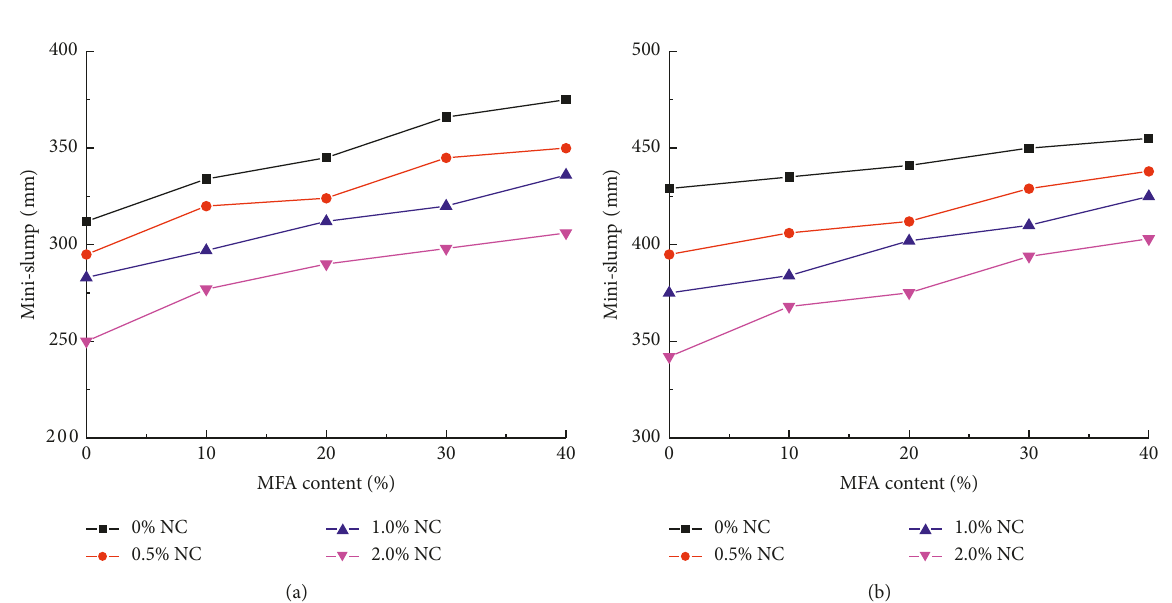
Figure 6: Mini-slump diameters of fresh grouts with a W/S ratio of 1.2: (a) 0% SP; (b) 1.5% SP.